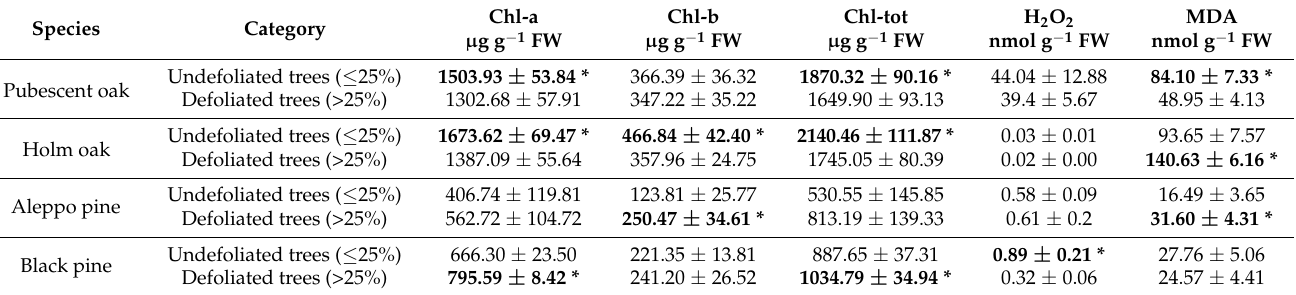
Table 2. Content of photosynthetic pigments in the leaves and needles (Chl-a, Chl-b, and Chl-tot), hydrogen peroxide (H 2 O 2 ), and malondialdehyde (MDA) of pubescent oak, holm oak, Aleppo pine, and black pine for the defoliated and undefoliated trees. Results are expressed as mean ± SD ( n = 3). Values marked in bold show a statistically significant difference between the defoliated and undefoliated trees of a plant species according to the Student’s t -test (* p <